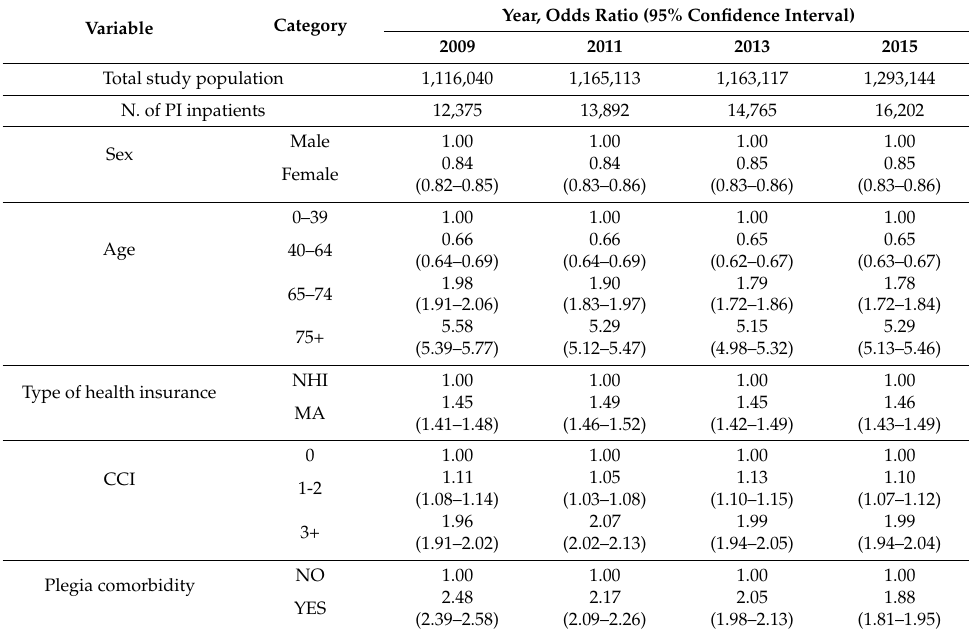
Table 4. Logistic regression analysis between PI diagnosis and socio-demographic factors among the overall population that used medical services between 2009 and 2015 in